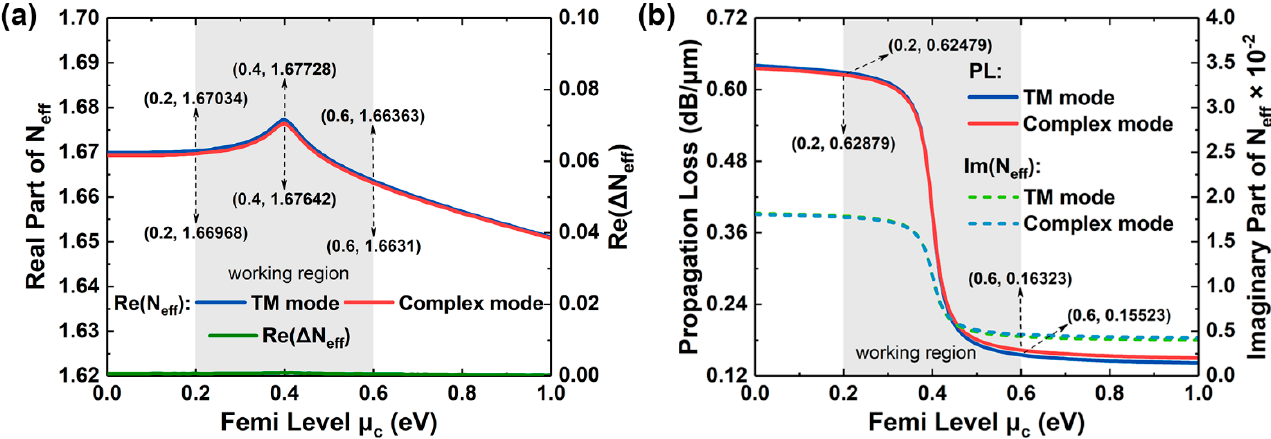
Figure 11. Re( N eff ) and Re( Δ N eff ), Im( N eff ) and PL of the TM mode and complex mode versus Femi level (chemical potential μ c ) from 0 to 1 eV are shown in (a) and (b),respectively.